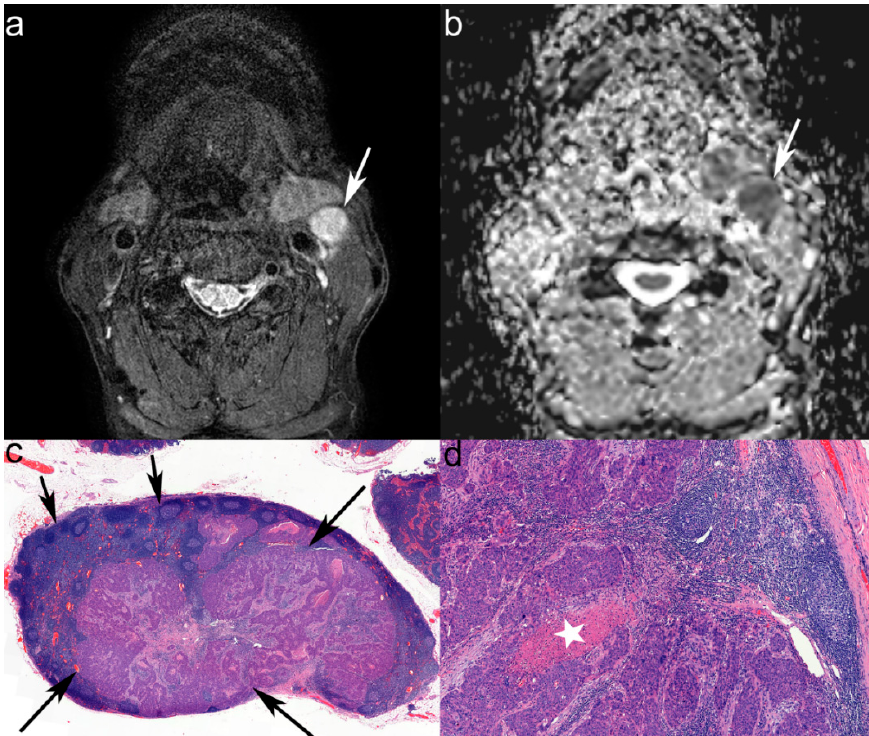
Figure 3. Images in a 62-year-old man with left tonsillar squamous cell carcinoma. ( a ) Axial T2-weighted image (T2-WI) with fat suppression shows about 1.8 cm sized lymph node (LN) in left neck level III (arrow). ( b ) This lymph node shows heterogeneously low apparent diffusion coefficient (ADC) value on the ADC map. The measured mean ADC value in this slice is 733 × 10 − 6 mm 2 /s. Under texture analysis, the measured complexity is 2022795, the normalized energy is 1363141 and the roundness was 0.303774, all of which are higher than the threshold for metastasis (245196, 667805 and 0.2473978, respectively). ( c ) On histopathologic examination, the metastatic deposit (long arrows) and the remaining normal lymphoid follicle structure (short arrows) can be seen (scan view, × 1). ( d ) On magnified view, the necrosis in the metastatic deposit can be demonstrated (asterisk, × 10).